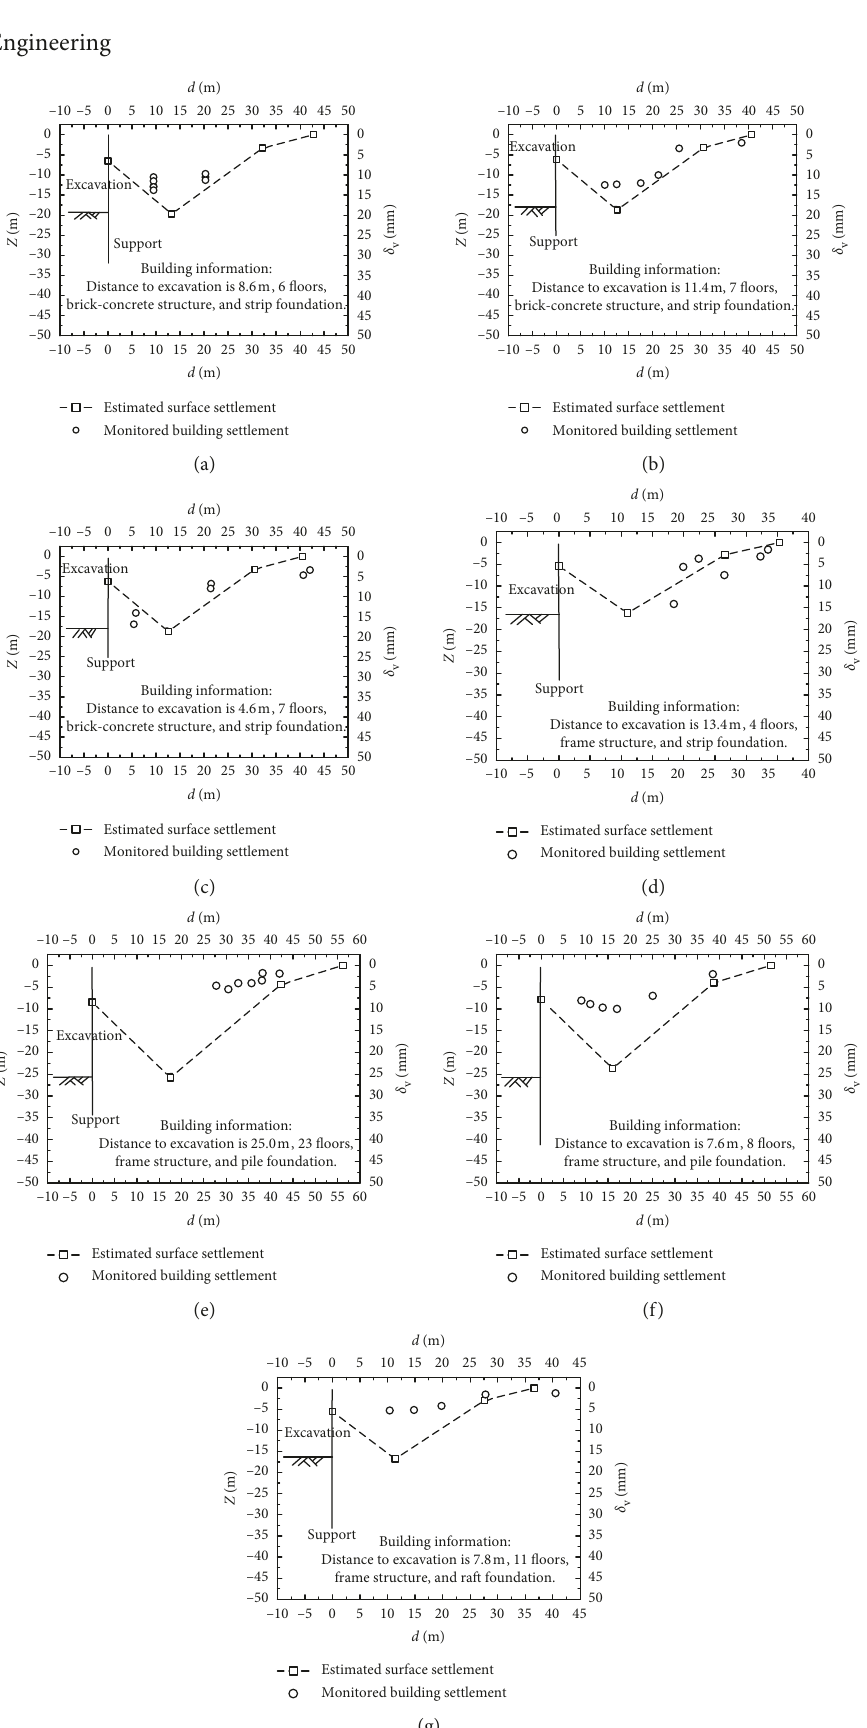
information: Distance to excavation is 7.8m, 11 floors, frame structure, and raft foundation.